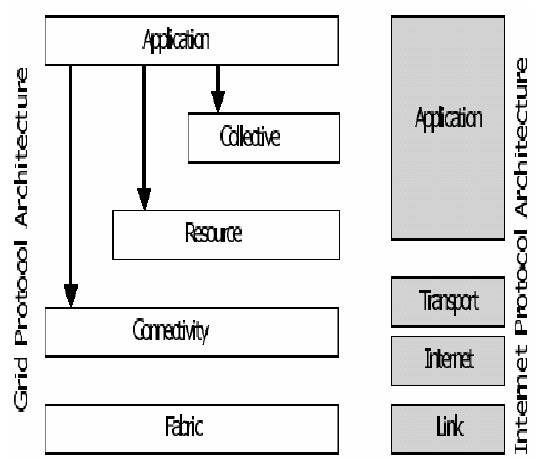
Figure 8: Grid Protocol Architecture & Internet